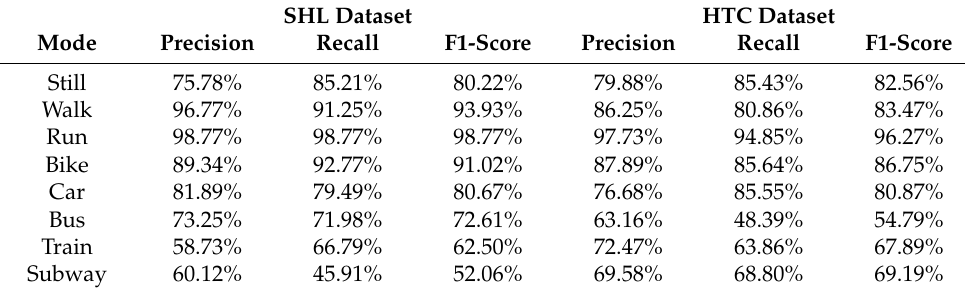
Table 5. Experimental results of removing temporal convolutional network.